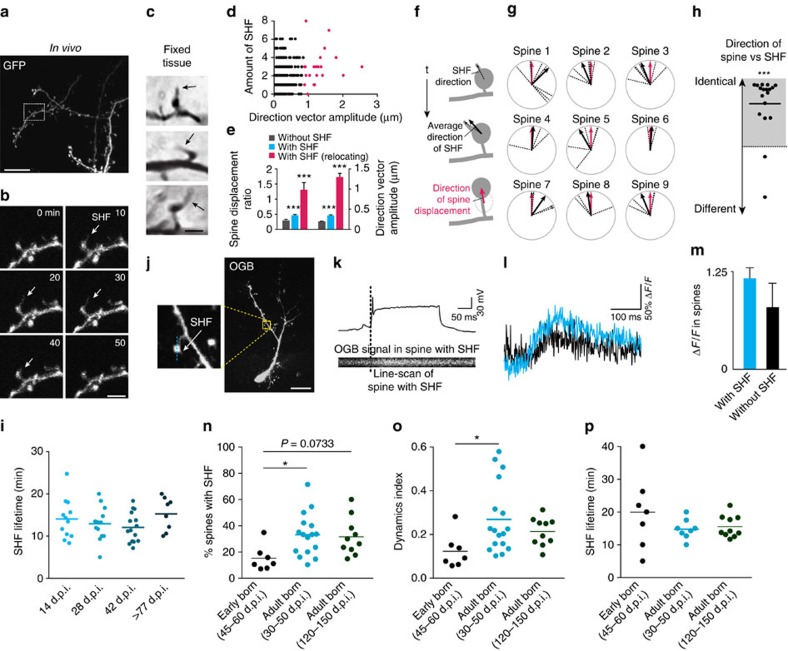
SHF determines the relocation of the spines of adult-born but not early-born GC.(a) Low-magnification image of an adult-born GC used for in vivo two-photon imaging. (b) Image sequence of the boxed region in a. The arrow indicates SHF. (c) GFP+ adult-born GC from fixed OB sections showing the presence of SHF. (d) Relationship between the number of SHF and the amplitude of the spine relocation direction vector (n=505 spines). (e) Normalized spine displacement and amplitude of direction vector for spines with and without SHF (n=161 and 344 spines, respectively). (f,g) Measurement of the correlation between the direction of SHF protrusion and the direction of spine relocation. Each dashed black line represents individual SHF, whereas solid black and red arrows represent the average direction of SHF protrusion and the direction of spine relocation, respectively. (h) The difference between the average angle of SHF protrusion and the spine displacement vector was calculated for spines showing relocation above the Z-score (n=21 spines, highlighted in red in d; ***P=2.88 × 10−5 using a one-sample t-test). (i) SHF lifetime values for different maturational stages of adult-born GC (n=12, 14, 15 and 8 cells from 10, 10, 9 and 5 mice for the 14, 28, 42 and 77 d.p.i. condition, respectively). (j) Example of an Oregon Green BAPTA (OGB)-filled td-tomato-expressing adult-born GC at 30 d.p.i. (k) Line scan Ca2+ imaging of a GC spine with SHF (lower panel) following single action potentials induced by the depolarization of the GC (upper panel). (l,m) Individual traces and quantification of Ca2+ transients in spines with (blue) and without (black) SHF (n=12 and 13 spines with and without SHF, 8 cells, 8 mice). (n–p) Quantification of the percentage of spines with SHF and SHF dynamics and lifetimes for a period of 1 h of in vivo two-photon imaging for early-born at 45–60 d.p.i. and adult-born GC at 30–50 and 120–150 d.p.i. (n=7, 16 and 10 cells from 6, 6 and 4 mice, respectively; *P<0.05 using one-way ANOVA). Scale bars: 20 μm, 5 μm, 2 μm for a–c, respectively; 20 μm for j. ANOVA, analysis of variance.